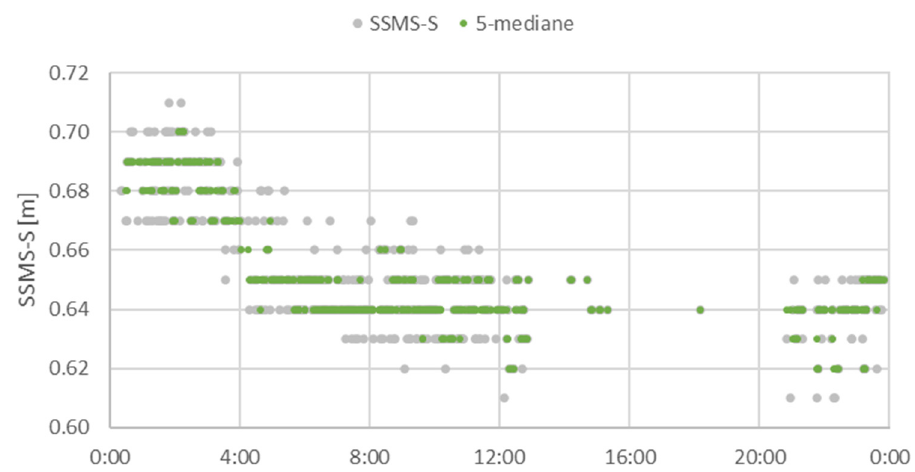
Figure 17. Roof support No. 59 pressure and tip to face distance (moving median of 5 values).